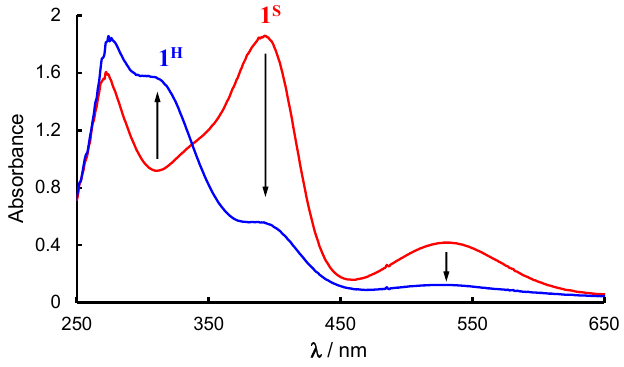
Figure 1. UV-vis spectrum of 1 S and the resultant 1 H formed by the reaction of 1 S with AZADOL.